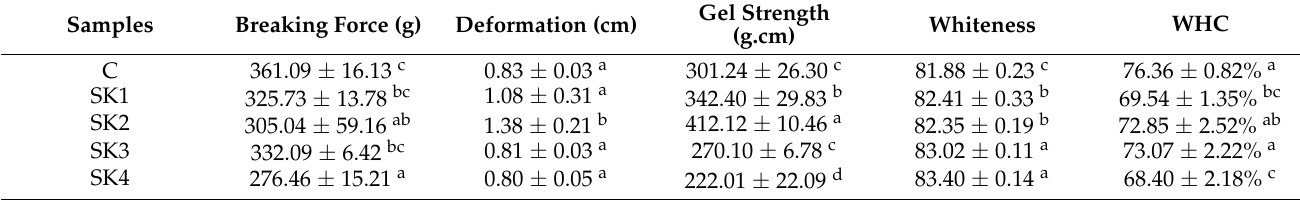
Table 3. Gel strength, whiteness, and WHC of surimi gels with different